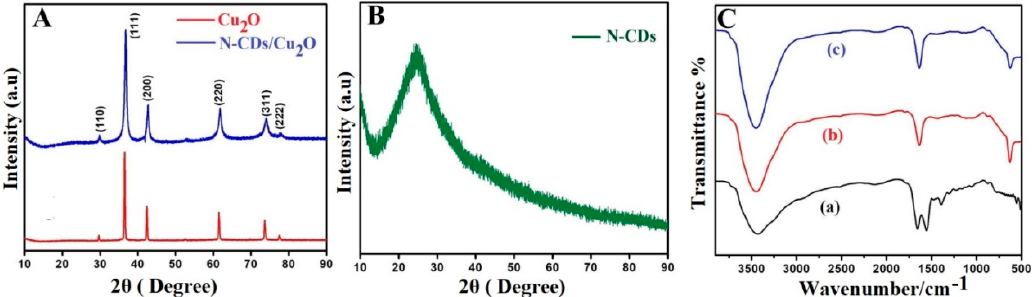
Figure 2. ( A ) XRD pattern of Cu 2 O and N-CDs / Cu 2 O composite, ( B ) XRD pattern of N-CDs; ( C ) FT-IR spectra of (a) N-CDs, (b) Cu 2 O and (c) N-CDs / Cu 2 O composite.